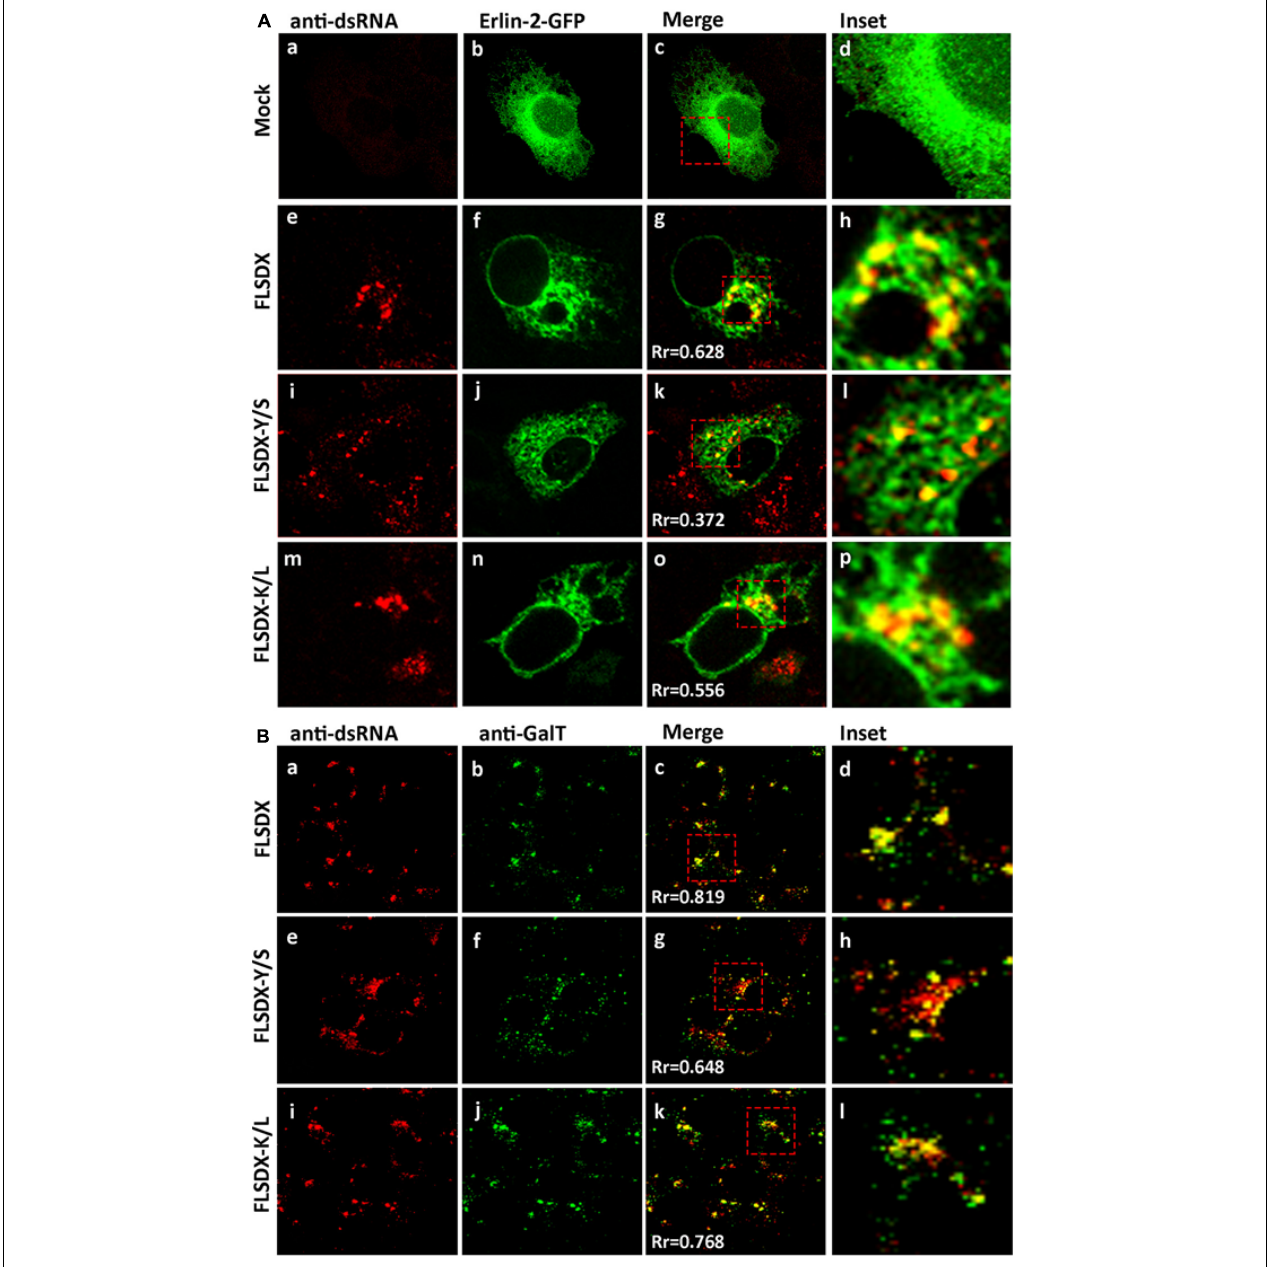
FIGURE 4 | CRAC mutant FLSDX viruses are impaired in their ability to recruit host proteins to the WNV KUN RC. (A) Vero cells transfected with recombinant eGFP-erlin-2 plasmids for 24 h and subsequently electroporated with CRAC mutant FLSDX viruses for an additional 48 h. Cells were immuno-stained with antibodies to dsRNA, and co-stained with Alexa Fluor 594 (panels a, e, i , and m ). Prominent co-localization between dsRNA and eGFP-erlin-2 proteins (panels b,f,j , and n ) is observed as a yellow hue in the merge and insert panels c–d , g–h , k–l and o–p . (B) Cells were immune-stained with antibodies specific to dsRNA and counterstained with species specific Alexa Fluor 594 (panels a, e , and i ), and with antibodies specific to GalT and counterstained with Alexa Fluor 488 (panels b,f, and j ). Co-incidental labeling is depicted as a yellow hue in the merged and insert panels on the right hand side (panels c–d , g–h , and k–l ).